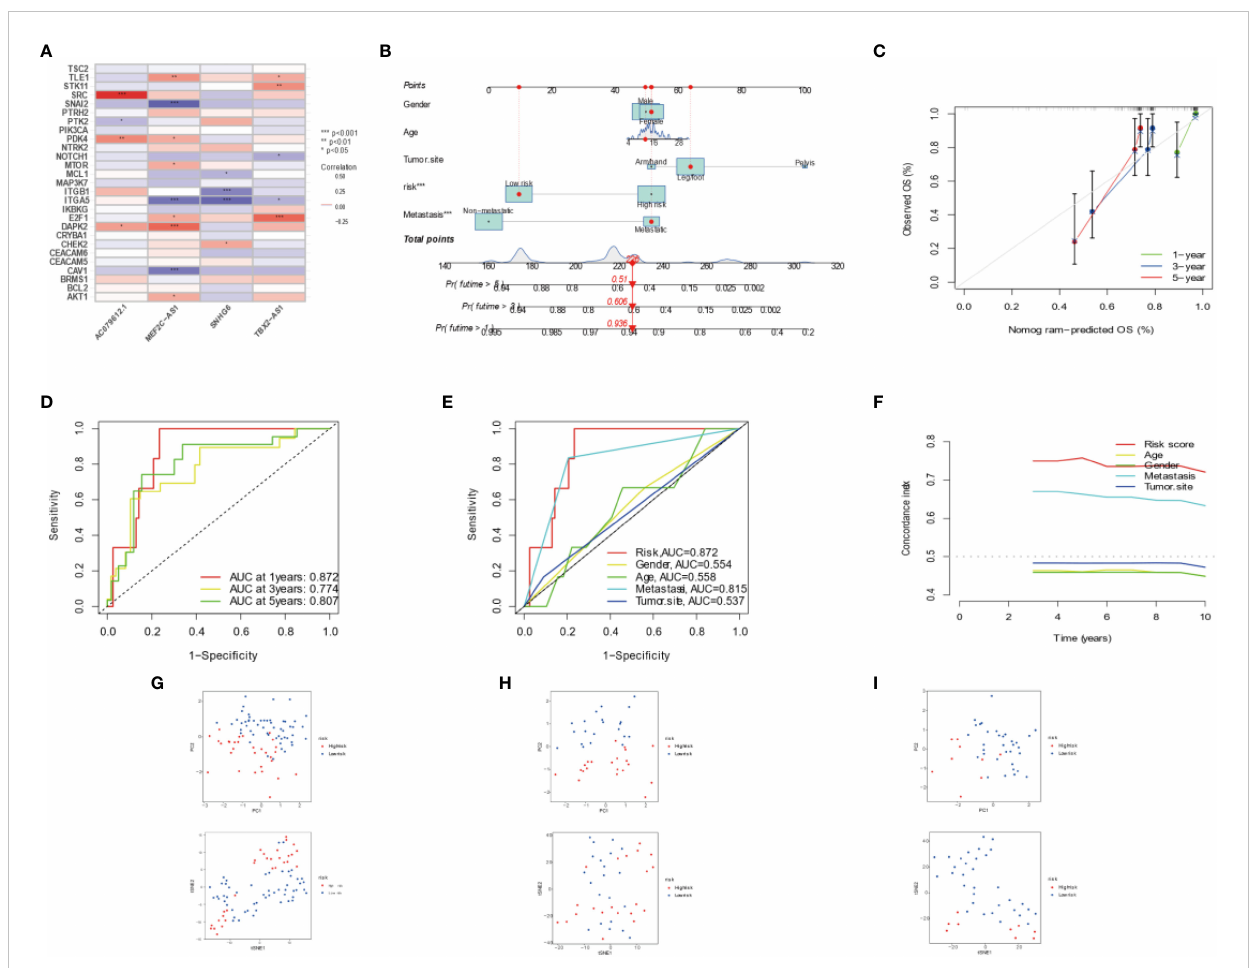
FIGURE 3 Combination of four DEARLncs signature and clinical features, analysis of PCA and t-SNE. (A) Relationship between four target genes and Anoikis- related lncRNAs in the entire cohort. (B) Nomogram based on age, gender, tumor site, metastasis, and risk in the TARGET database. (C) Calibration curves illustrated the consistency between predicted and observed 1-, 3-, and 5-year survival rates in OS patients depending on the prognostic nomogram. (D, E) The ROC curves for 1, 3, 5 years and clinical survival in the TARGET cohort. (F) The C-index was used to determining the prognostic accuracy of risk scores and addition clinical factors in entire cohort. (G – I) The PCA and t-SNE in entire, training, testing sets,